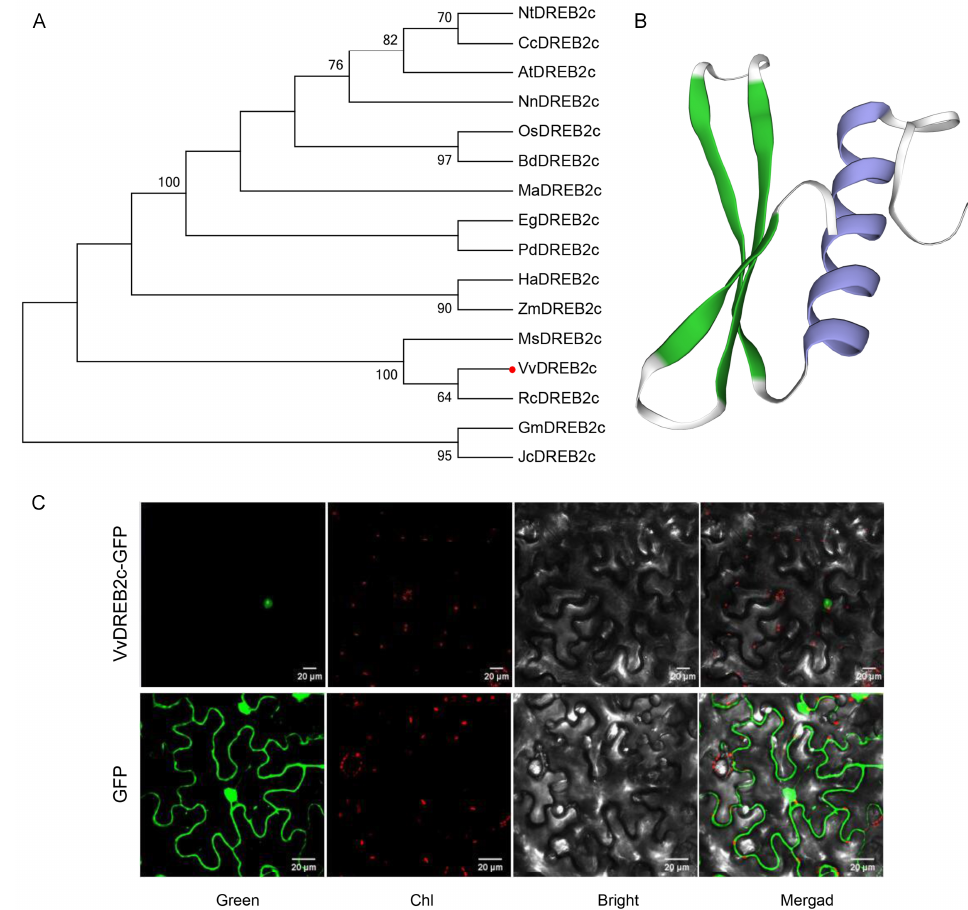
Figure 2. VvDREB2c sequence, structure, and localization. ( A ) Phylogenetic analysis of VvDREB2c (red dot) and DREB2c-related proteins from Nicotiana tabacum , Cajanus cajan , Arabidopsis thaliana , Nelumbo nucifera , Oryza sativa japonica , Brachypodium distachyon , Musa acuminata , Elaeis guineensis , Phoenix dactylifera , Helianthus annuus , Zea mays , Malus sieversii , Ricinus communis , Glycine max , and Jatropha curcas . ( B ) Prediction of VvDREB2c tertiary structure. ( C ) Subcellular localization of VvDREB2c in tobacco; Green: green fluorescent protein (GFP) signal; Chl: red signal is chlorophyll fluorescence signal; Bright: protoplast image in bright field; Merged: combination of Green and Chl images.